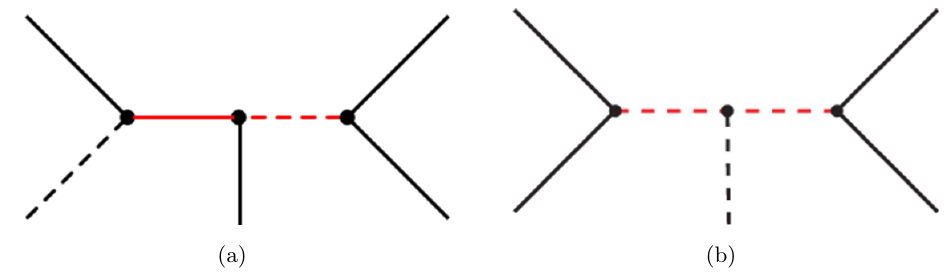
Figure 1 . Diagrams that generate operators of dimension 7 via (a) scalar and vectorlike fermion exchange, and (b) by pure scalar